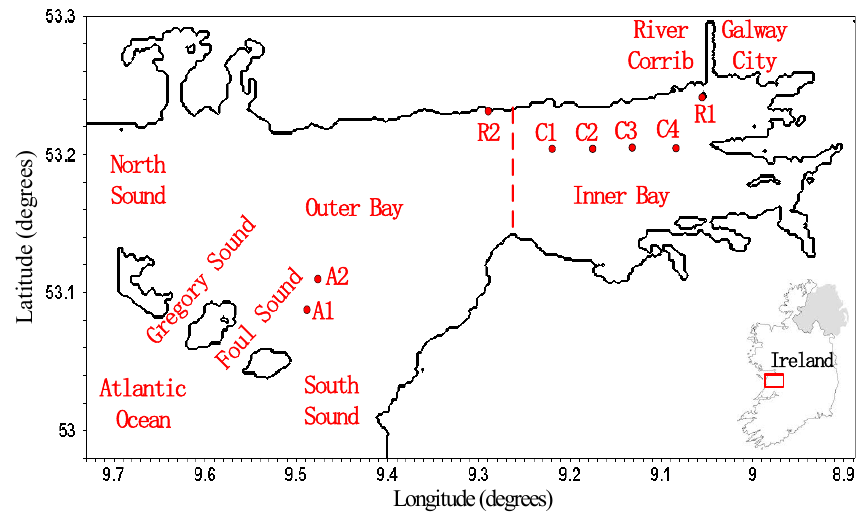
Figure 1. Galway Bay study area (R1 and R2 indicate radar station at Mutton Island and Spiddal, respectively; A1 and A2 indicate ADCP sites; C1–C4 indicate reference points for comparison).